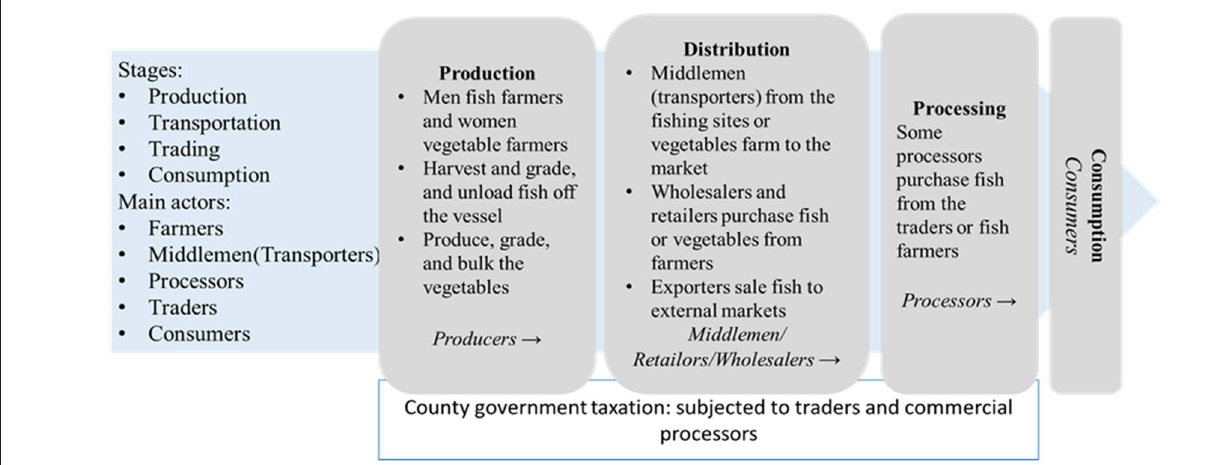
FIGURE 4 | The status quo of fish and TLV value chains in Kisumu.